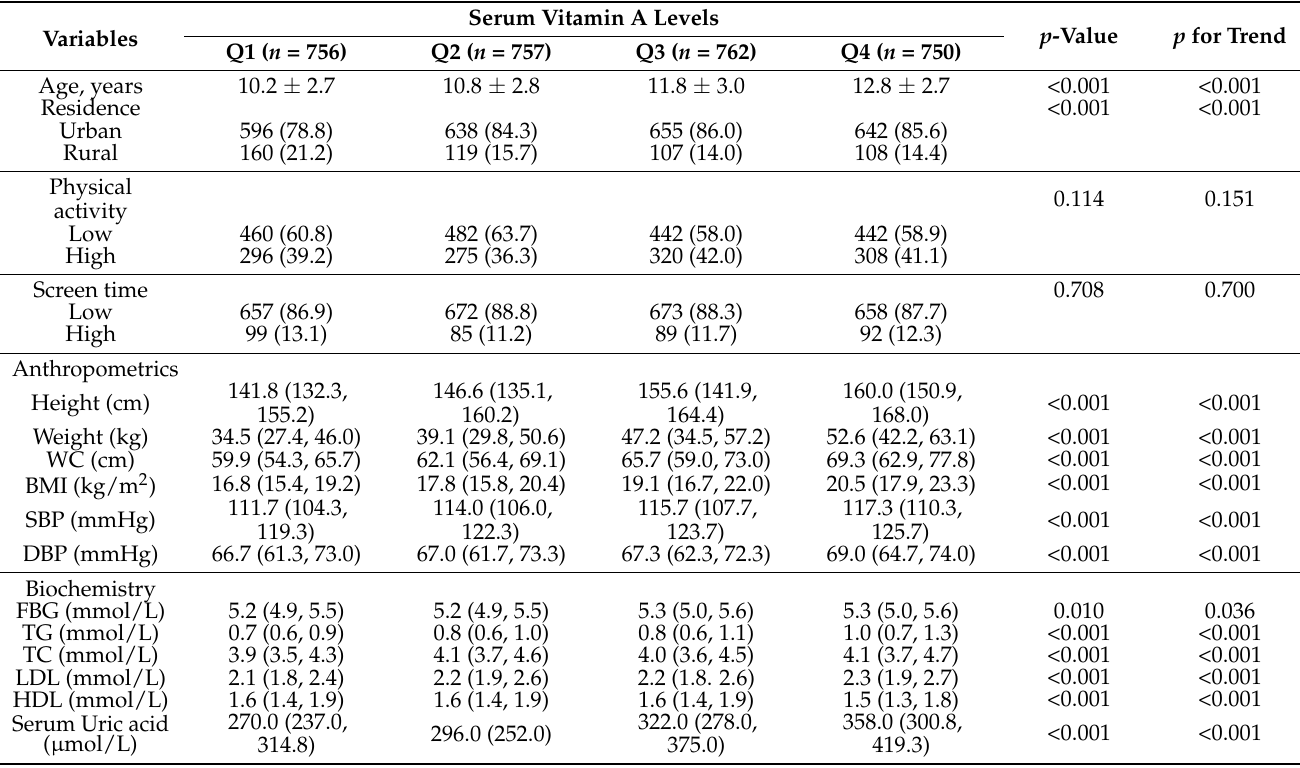
Table 1. Basic information of male and female